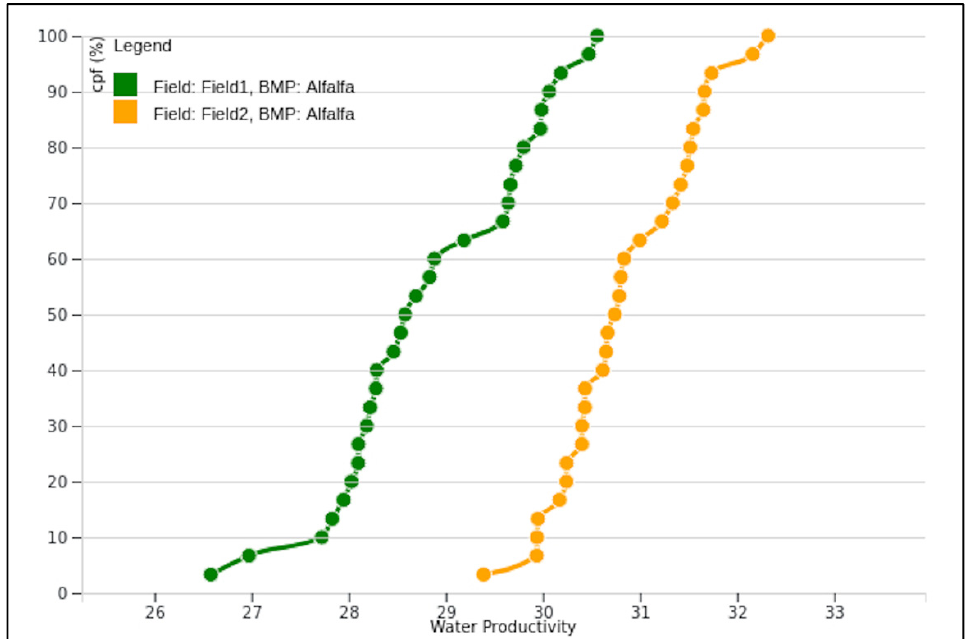
Figure 8. Water Productivity for Field 1 (near Tulare, California) and Field 2 (near Davis, California).